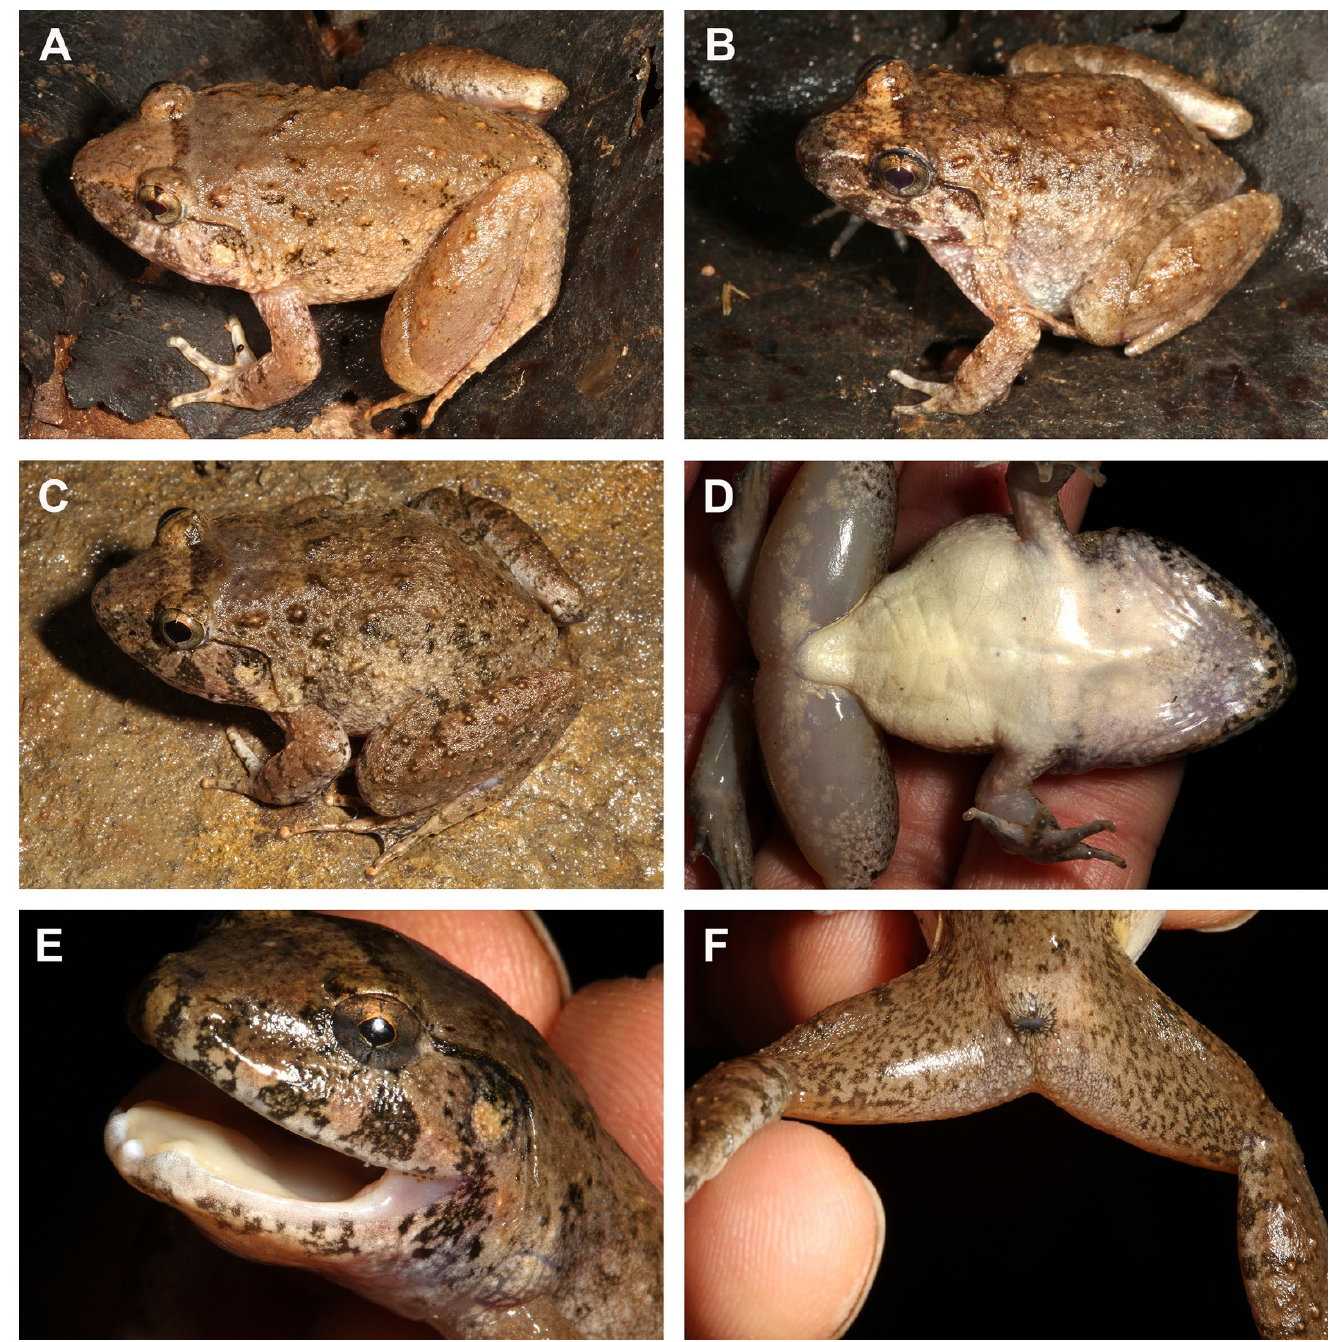
Figure 10. Limnonectes bagoensis n. sp. in life. ( A ) Male holotype, SMF 104090; ( B ) female paratype, SMF 104091; ( C – F ) male paratype, SMF 106038. Photos by G.K.